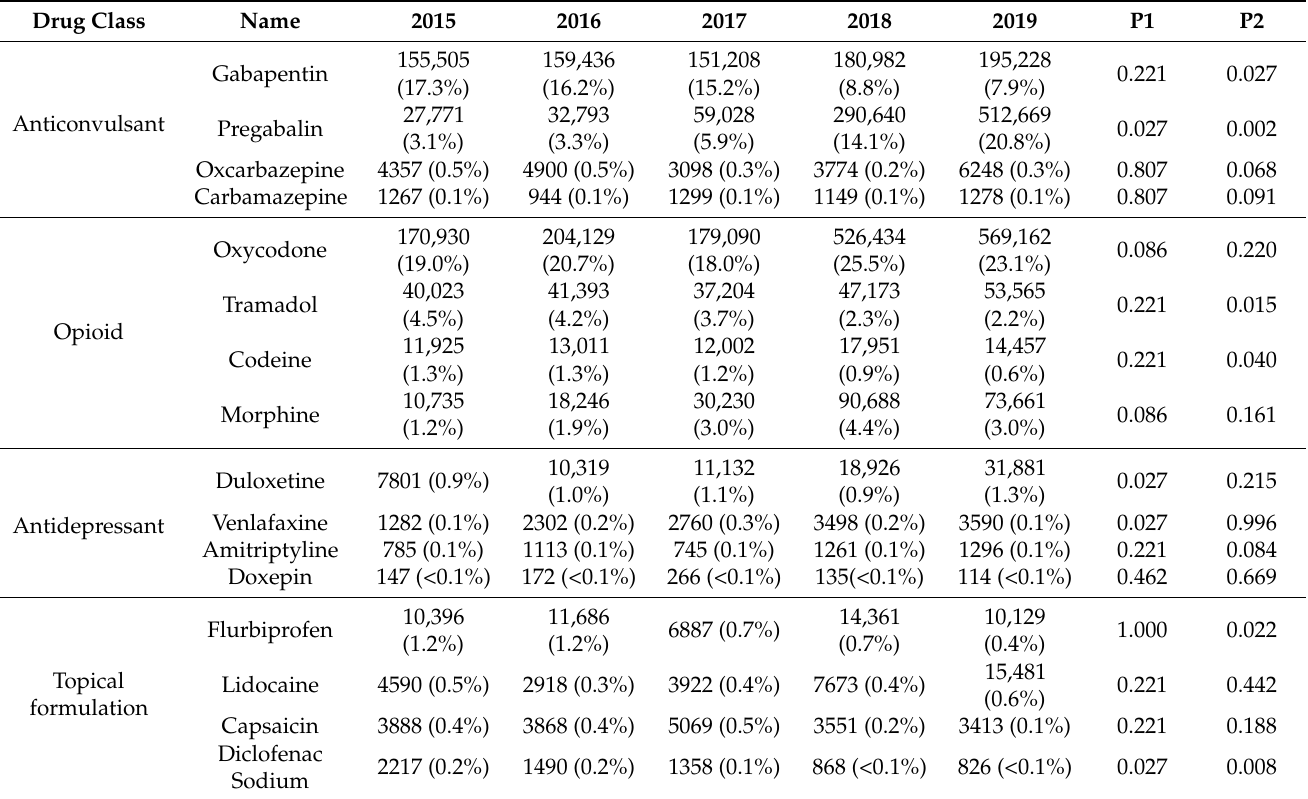
Table 3. Yearly cost of specific drugs from 2015 to